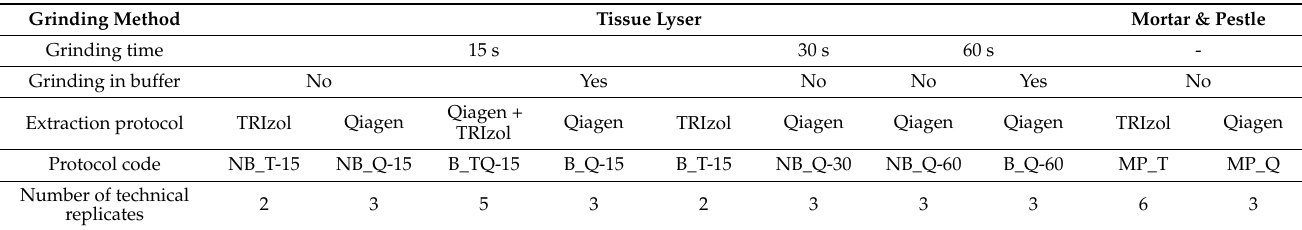
Table 1. The scheme of the experiment.